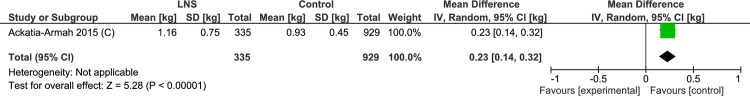
Forest plot: Lipid-based nutrient supplement versus Specially formulated micronutrient fortified foods, outcome: 1.15 Weight Gain Total [kg].